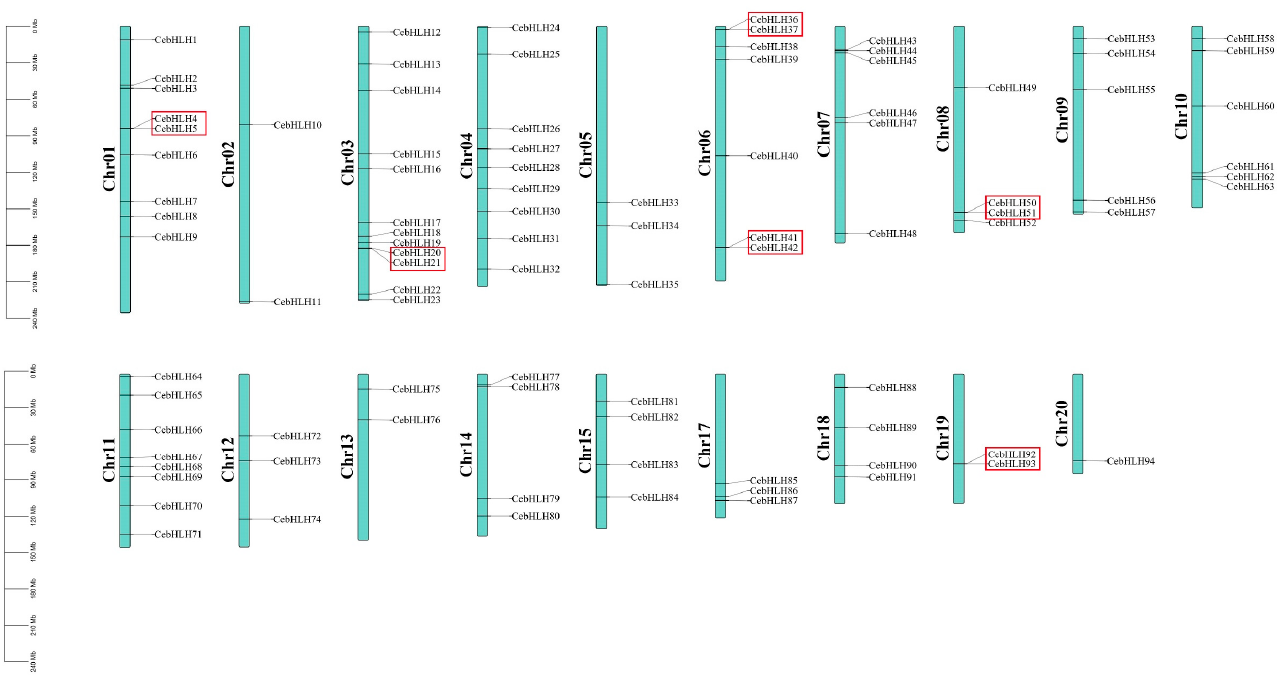
Figure 5. Chromosomal localization and gene duplications of CebHLHs . The tandemly duplicated genes are represented by red boxes. The scale bars on the left are the length (Mb) of the chromosomes of C. ensifolium .